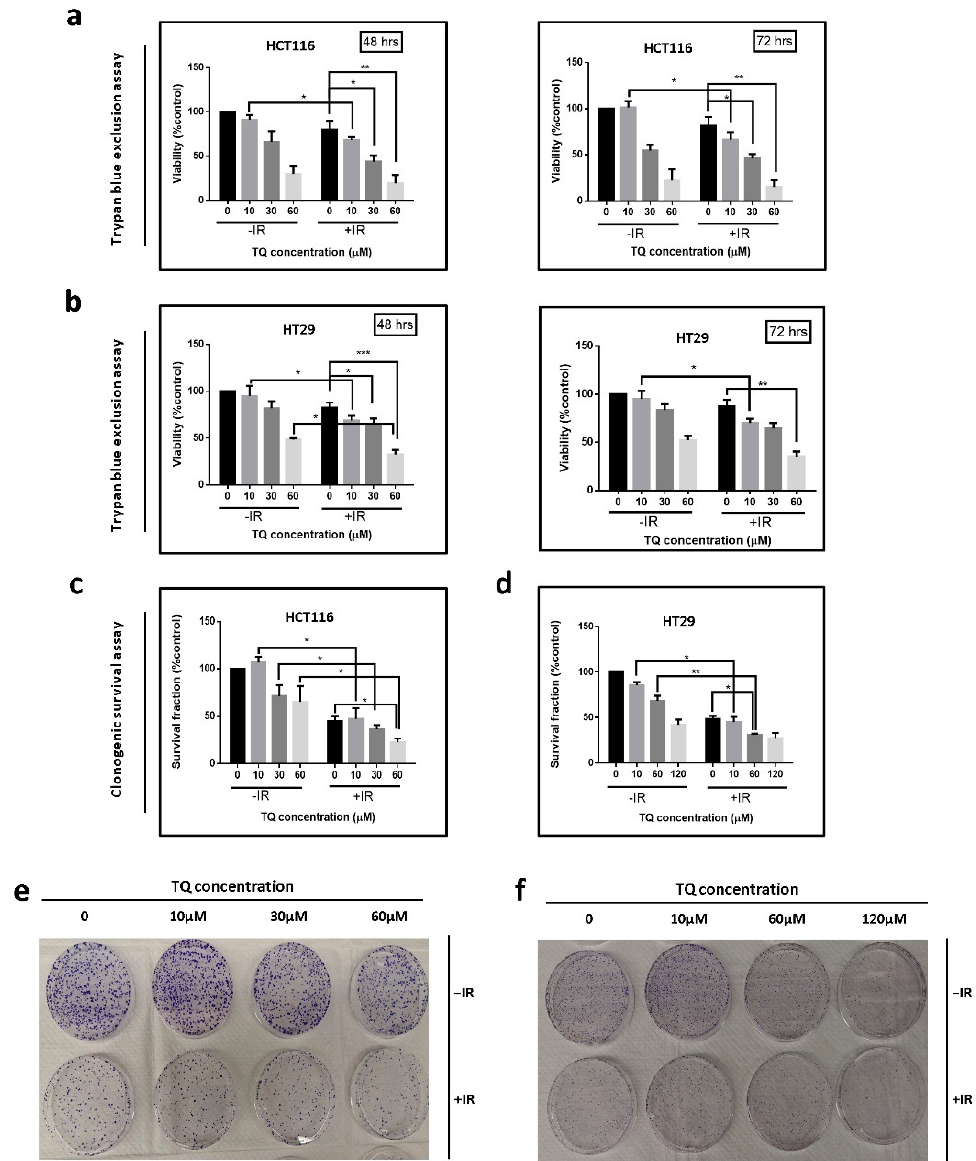
Figure 1. TQ sensitizes colorectal cancer cells to radiation and reduces their cell viability and colony forming ability. ( a , b ) HCT116 and HT29 cells were either left untreated or were incubated with TQ alone, IR alone (2 Gy) or combinations for 48 or 72 h. At the specific time point, cell viability was determined using trypan blue exclusion assay. ( c – f ) Clonogenic survival assay was used to determine effect of TQ and IR on the long-term survival of HCT116 ( c ) and HT29 ( d ) cells. Cells were treated with TQ, IR, or combinations, after which they were collected and seeded in treatment-free media at low density. After 7–10 days, the resulting colonies were fixed, stained with crystal violet and counted. Representative images of HCT116 ( e ) and HT29 ( f ) colonies are shown. Results are expressed as percentage of the studied group as compared to its control. Data represent an average of three in-dependent experiments. The data are reported as mean ± SEM (* p < 0.05; ** p < 0.01; *** p < 0.001).